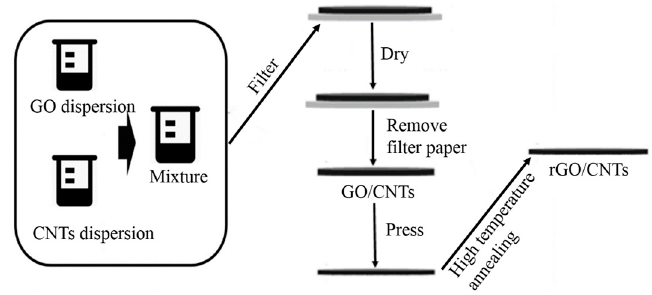
Figure 1. Illustration of the preparation process for the reduced graphene oxide / carbon nanotube (rGO / CNT) composite films.